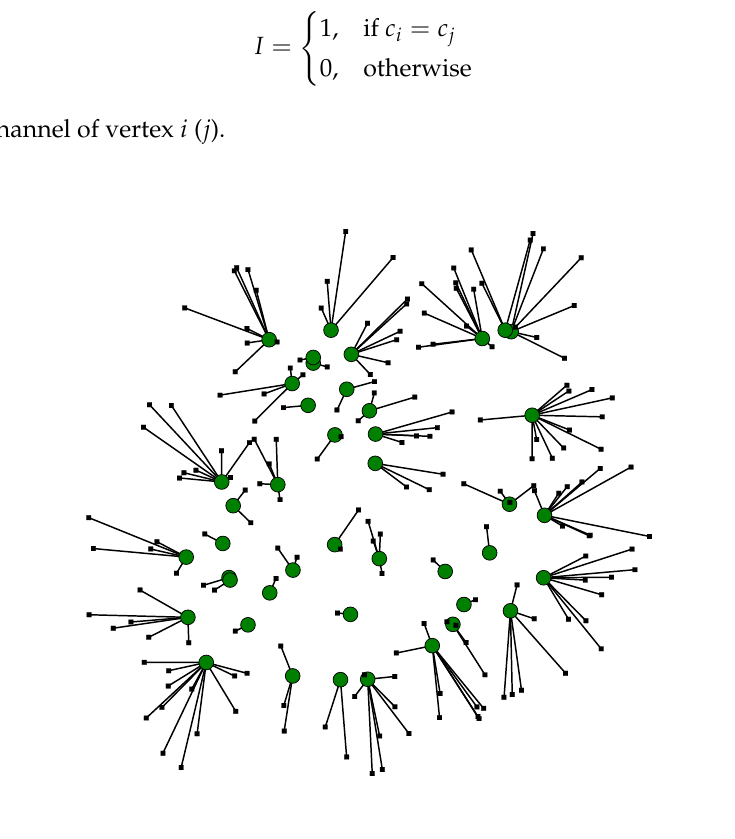
Figure 1. Example of a connectivity layer.